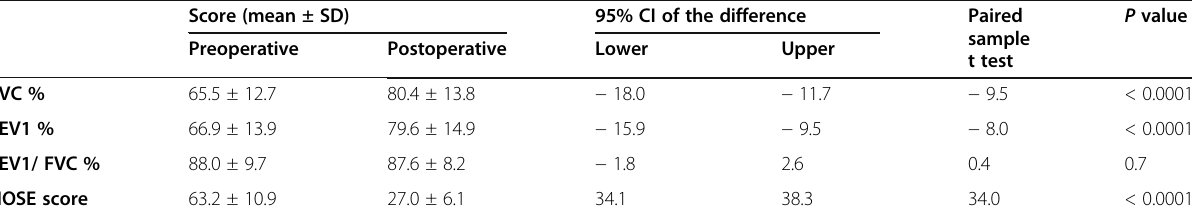
Table 3 Pulmonary functions and nasal obstruction score pre and postoperative